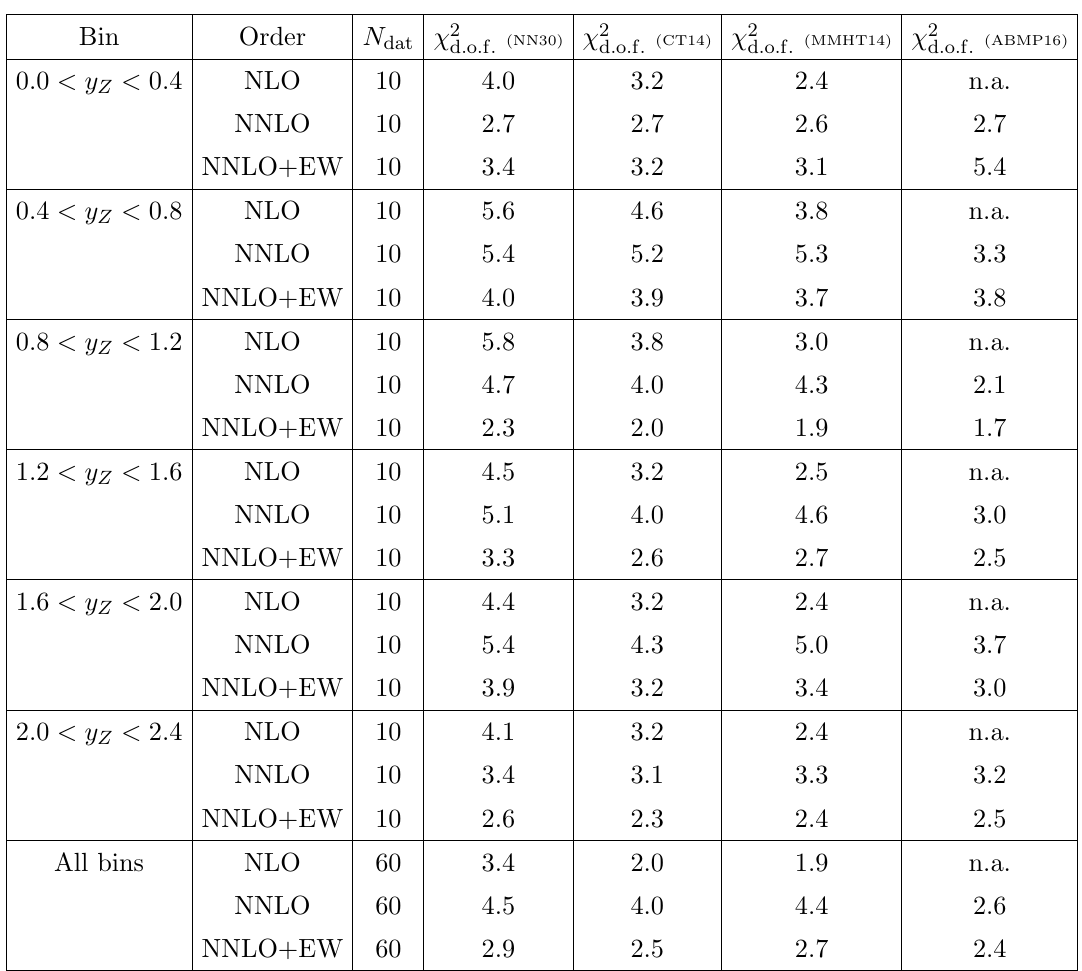
Table 3 . Same as table 1 for the ATLAS 8 TeV p Z bins before their inclusion in the